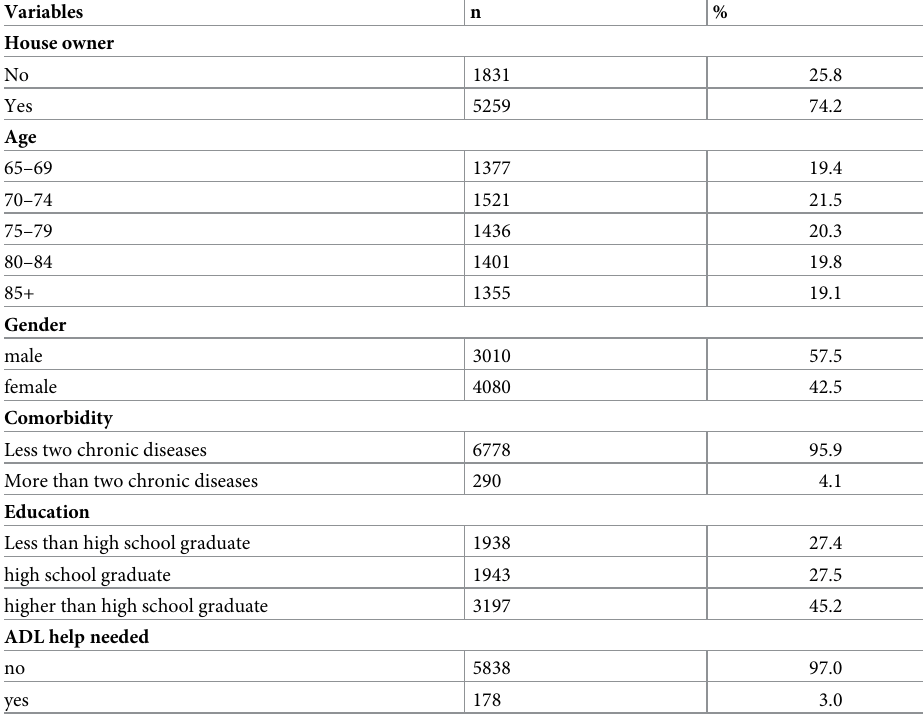
Table 1. Demographics characteristics of study subjects (n = 7090).